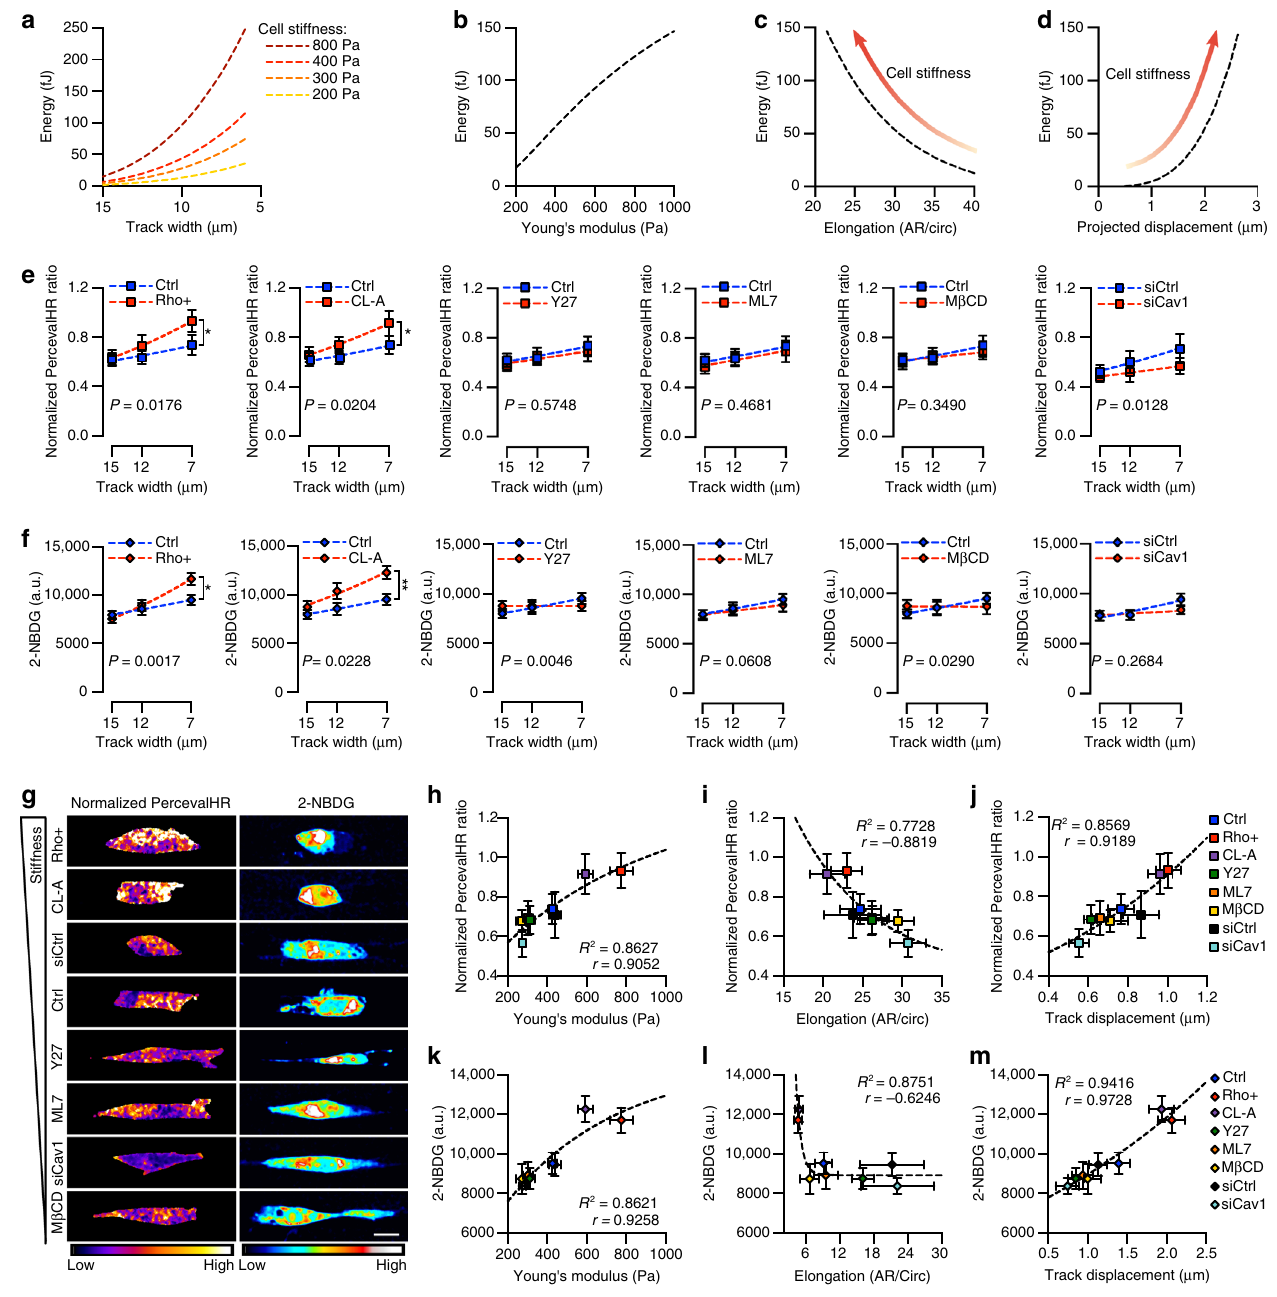
Fig. 4 Cell stiffness-mediated increases in cellular ATP:ADP ratio and glucose uptake are correlated with matrix deformation. a Model predictions for energy requirements for migration into tracks of varying size with increasing cell stiffness. b – d Model predictions for energy requirements for migration ( b ), cell elongation ( c ), and track displacement ( d ) as a function of cell stiffness in 7 μ m microtracks. e Normalized PercevalHR ratio with increasing con fi nement following pharmacological treatments and siCav1 knockdown ( n = Ctrl: 111, 91, 118; Rho + : 111, 92, 107; CL-A: 121, 95, 100; Y27: 127, 117, 135; ML7: 114, 95, 107; M β CD: 116, 105, 123; siCtrl: 63, 49, 53; siCav1: 68, 46, 55 cells for 15, 12, 7 μ m microtracks). f 2-NBDG uptake with increasing con fi nement following pharmacological treatments and siCav1 knockdown ( n = Ctrl: 46, 29, 36; Rho + : 44, 41, 42; CL-A: 48, 40, 49; Y27: 61, 37, 46; ML7: 52, 38, 36; M β CD: 40, 24, 28; siCtrl: 46, 17, 22; siCav1: 46, 28, 21 cells for 15, 12, 7 μ m microtracks). g Normalized PercevalHR ratio and 2-NBDG heatmap for cells of differing stiffness following treatment in 7 μ m microtracks. h – j Normalized PercevalHR ratio as a function of cell stiffness ( h ), cell elongation ( i ), and track displacement ( j ) in 7 μ m microtracks across cell stiffness altering treatments. k – m 2-NBDG uptake as a function of cell stiffness ( k ), cell elongation ( l ), and track displacement ( m ) in 7 μ m microtracks across cell stiffness altering treatments. Data shown as mean ± s.e.m.; dashed lines show exponential growth ( e , f , j , m ); one-phase association ( h , k ), and one-phase decay ( i , l ); two-tailed Mann – Whitney test and extra sum-of-squares F-test for comparing curves ( e , f ); * P < 0.05, ** P < 0.01. Scale bar, 15 μ